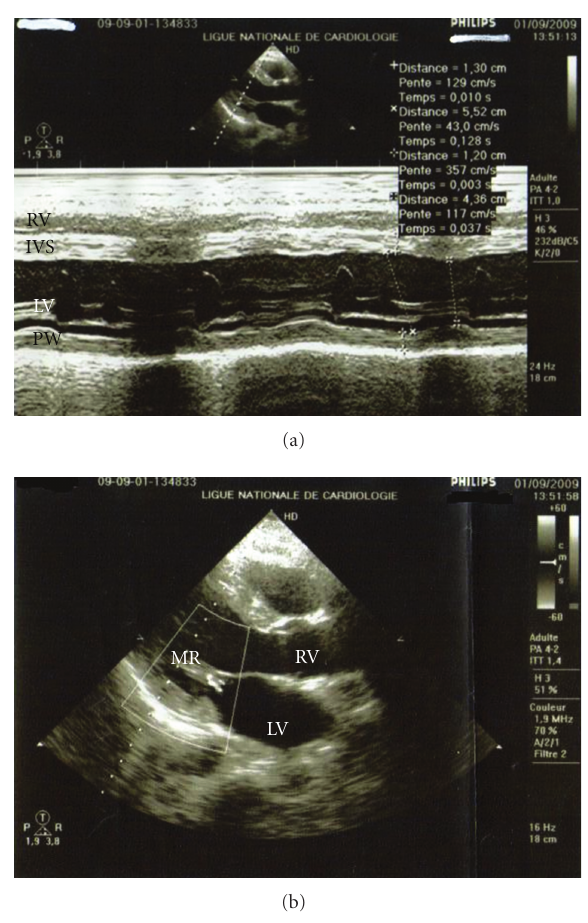
Figure 2: (a) Echocardiographically parasternal long axis depicted improvement of ventricle function. First echocardiogram obtained four days after admission showed LVEF of 48% (calculated by Simpson method). Hypokinesis of the septum and parietal wall of the left ventricle. (b) Second echocardiogram taken 24 days after BWS envenomation depicted good evolution of mitral regurgitation becomes grade I. LVEF was